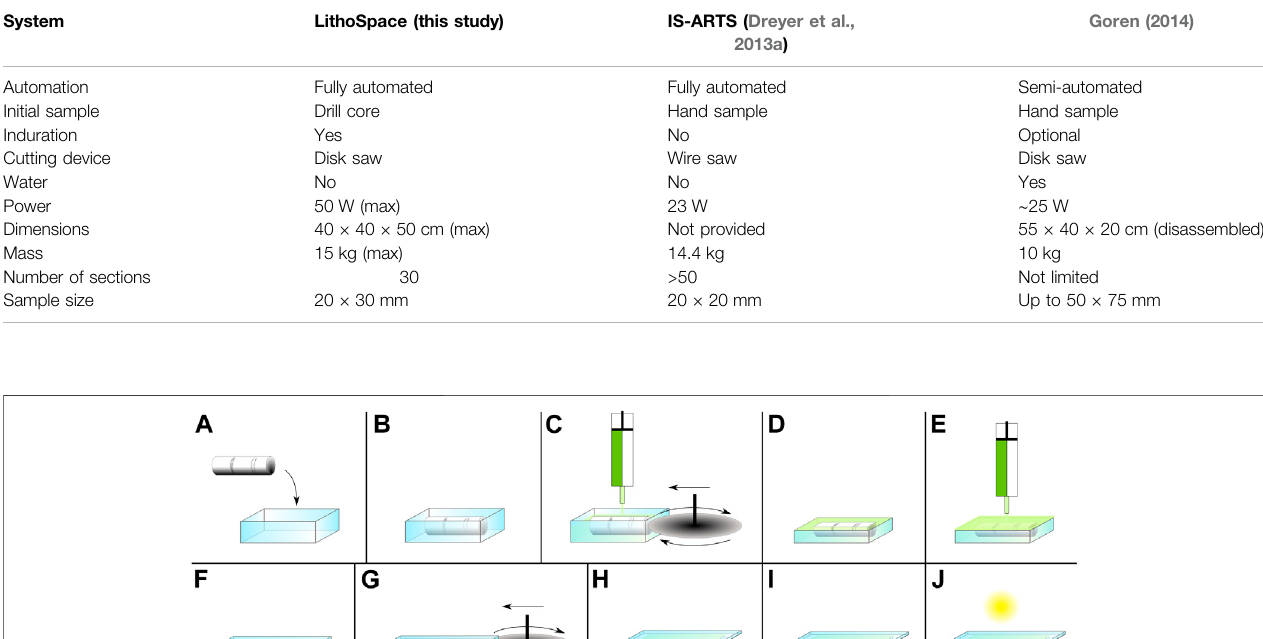
Frontiers in Astronomy and Space Sciences |